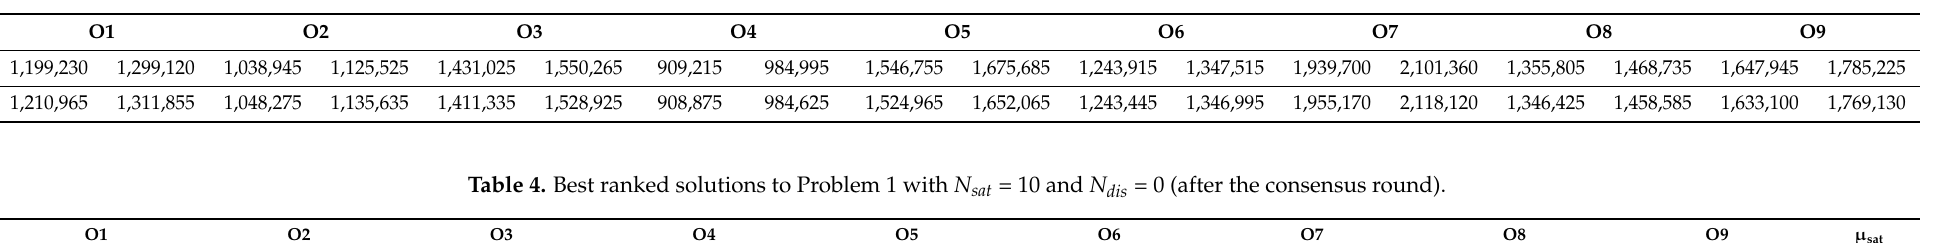
Table 3. Best consensus solution to Problem 1 with N sat = 9 and N dis = 0.